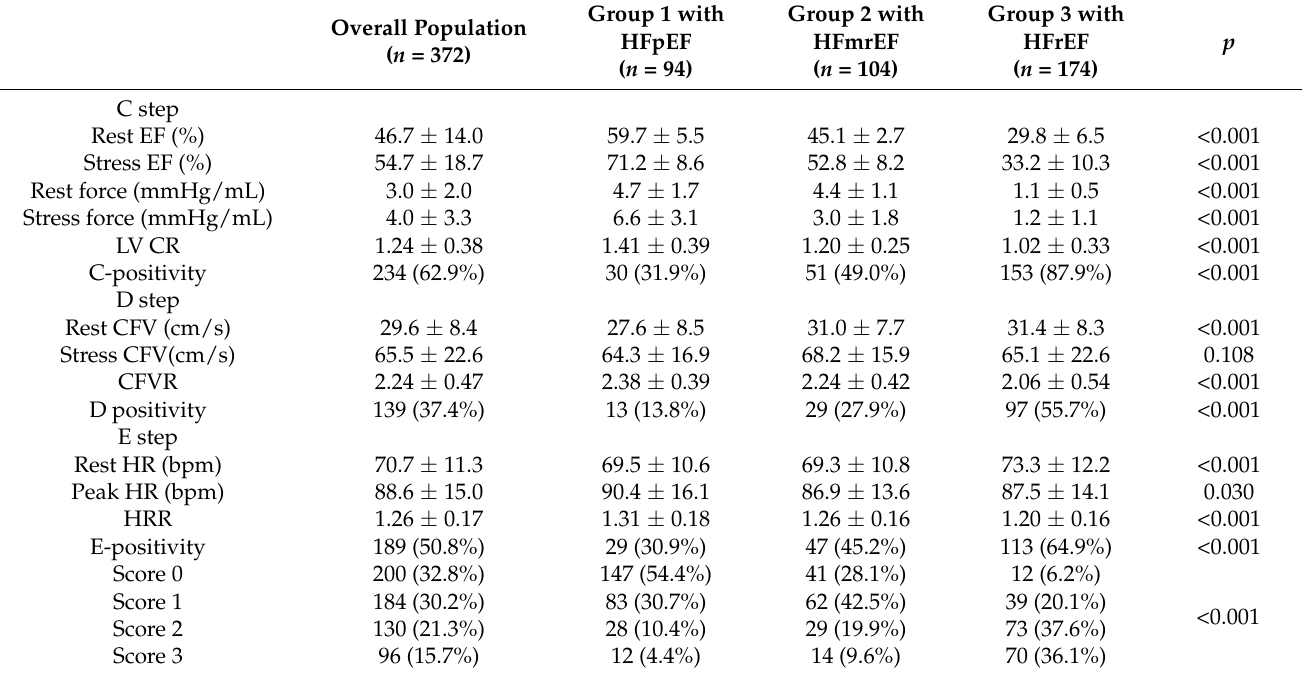
Table 2. Stress echo